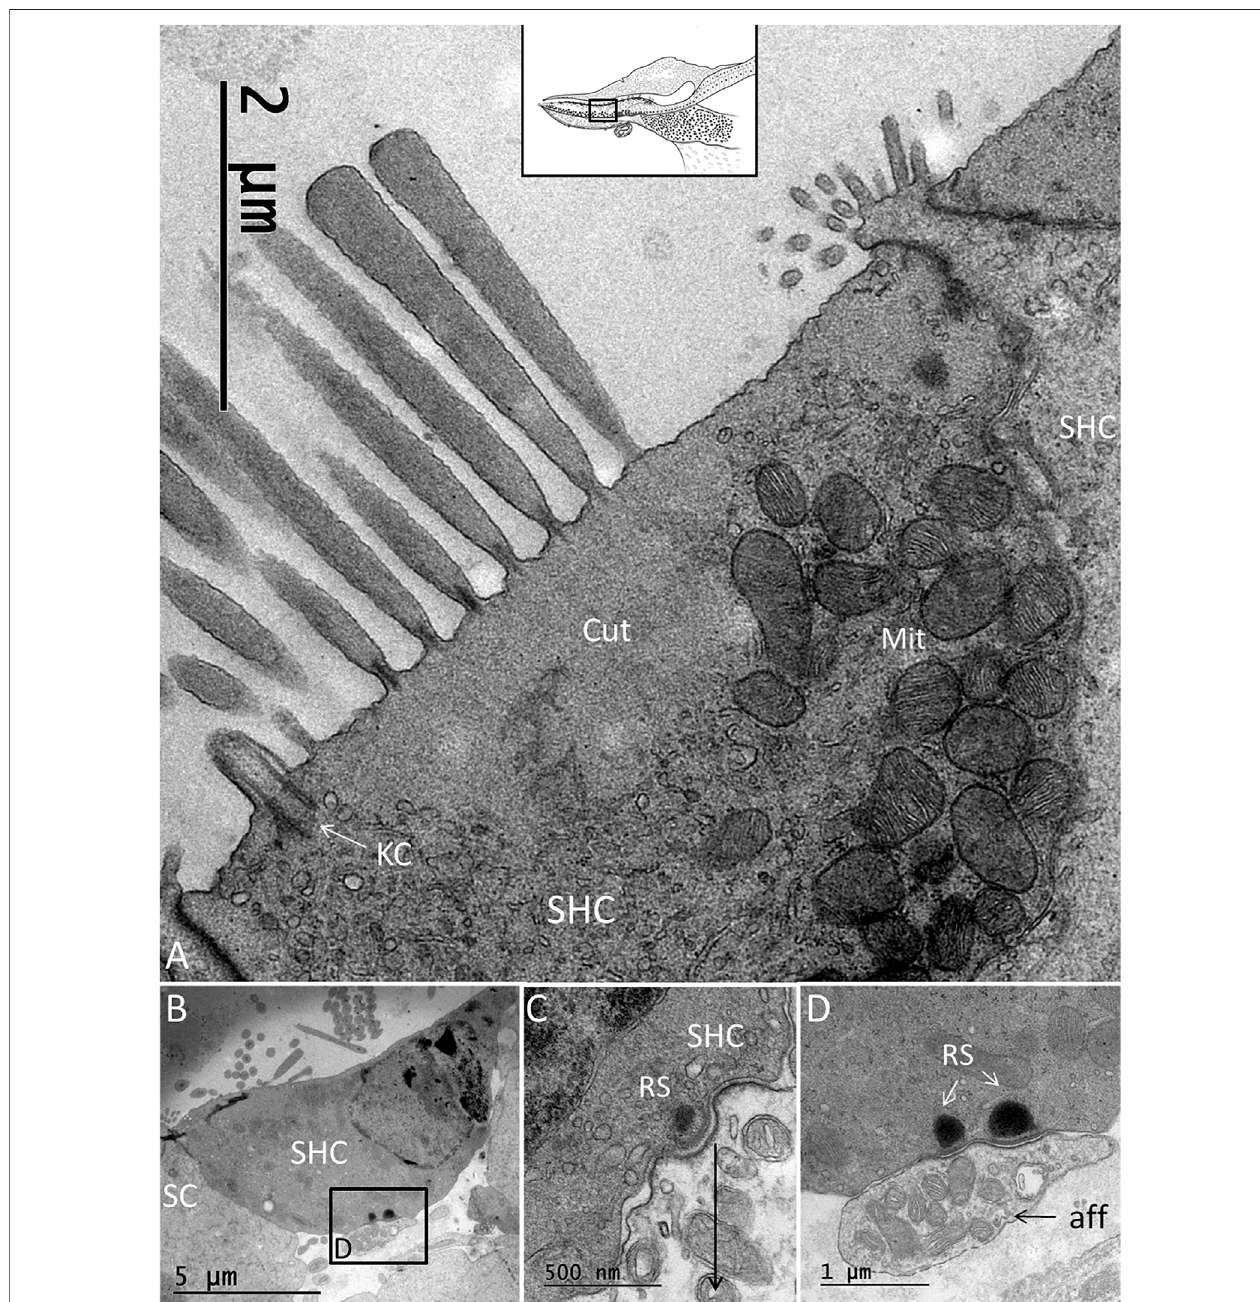
FIGURE5|(A) .TEMofanSHCofthe C.rhombifer . (B) .OneafferentterminalisassociatedwithRSs(framed areamagni fi edinD. (C) .SHCwithanRS.Thereisno halo of synaptic vesicles. (D) . Framed area in B is magni fi ed and shows two RSs at the afferent (aff)